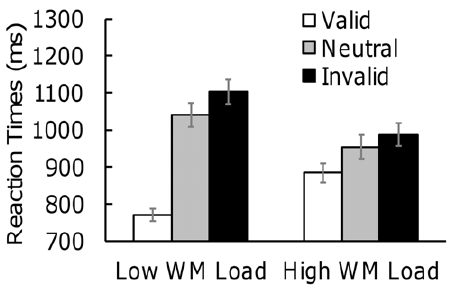
Figure 2. Mean correct RTs (ms) in a visual search task. Note. Error bars represent standard errors. WM=Working